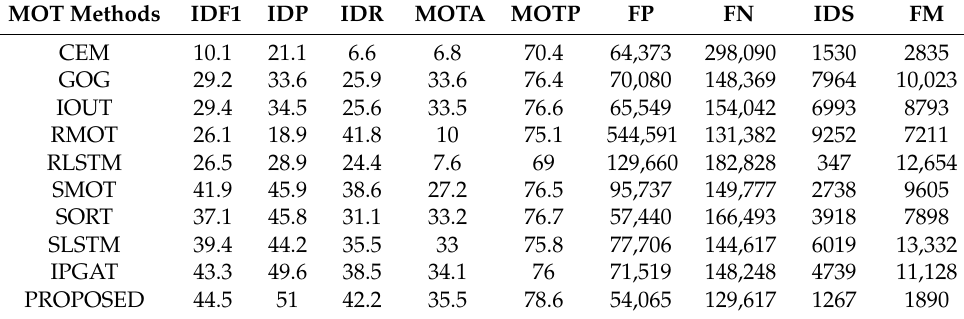
Table 3. SSD (single-shot detector) evaluation with respect to performance metrics. MOT: multiple object tracking; IDP: identification precision; IDR: identification recall. MOTA: multiple object tracking accuracy. MOTP: multiple object track- ing precision. FP: false positive. FN: false negative. IDS: identification switches, and the total number of times a trajectory is fragmented (FM).